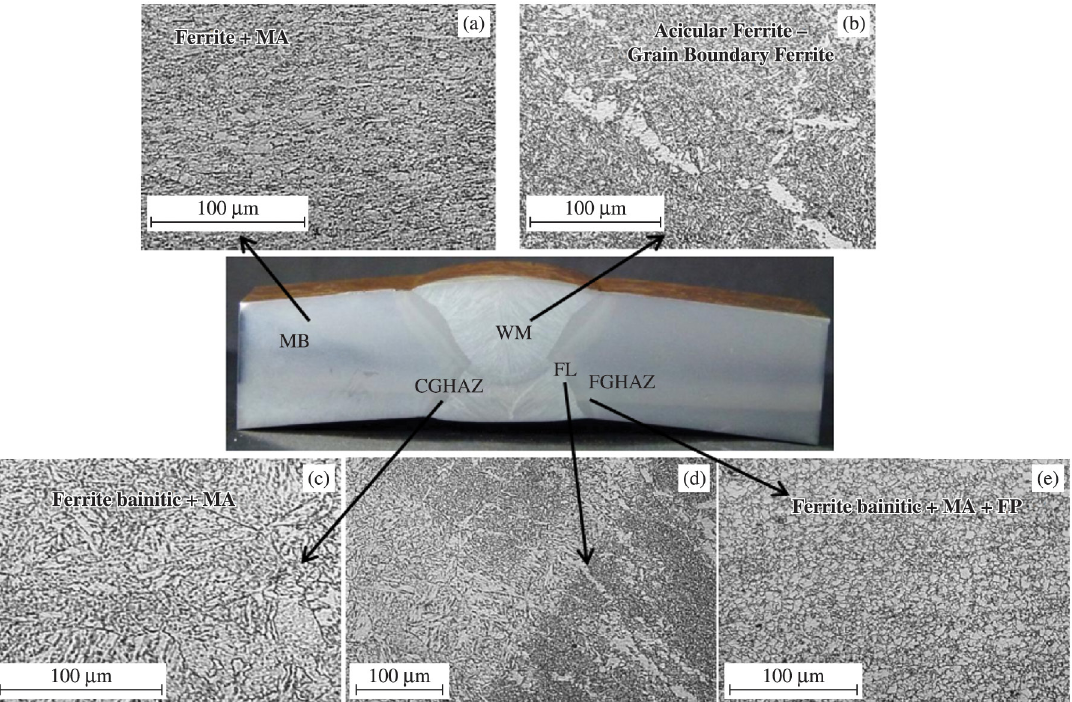
Figure 3. Microstructural characterization of the welded joint. a) Base metal (BM). b) Weld metal (WM). c) Coarse grain heat affected zone (CGHAZ). d) Fusion line (FL). e) Fine grain heat affected zone (FGHAZ).